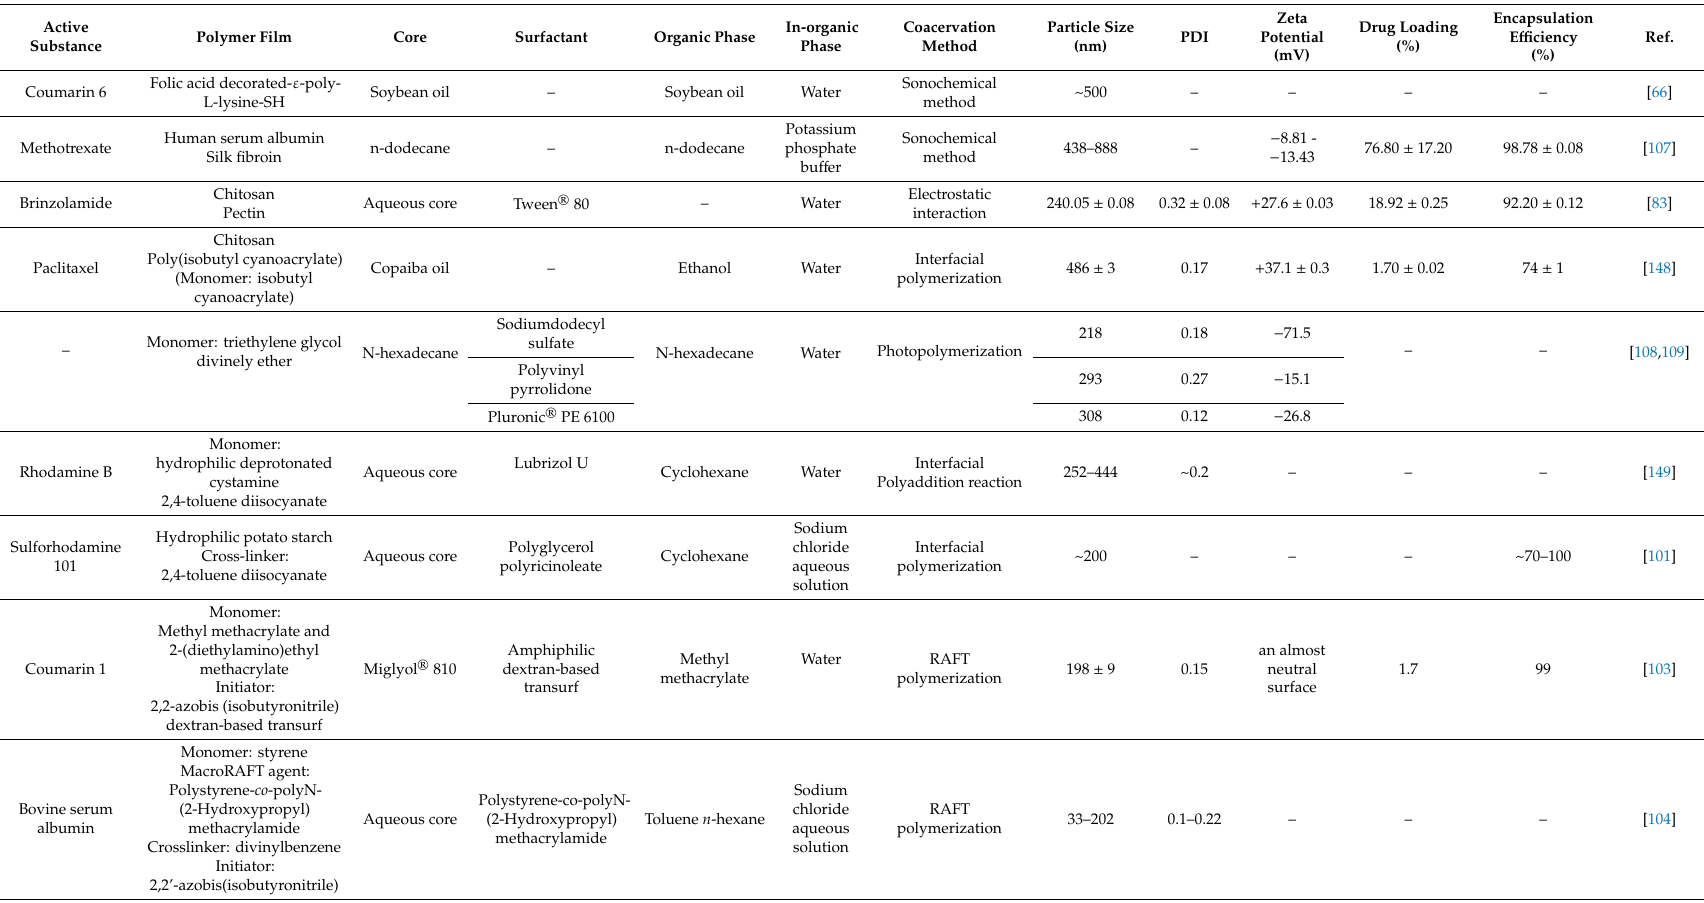
Table 3. Examples of polymeric nanocapsule formulation emulsion–coacervation method in recent five